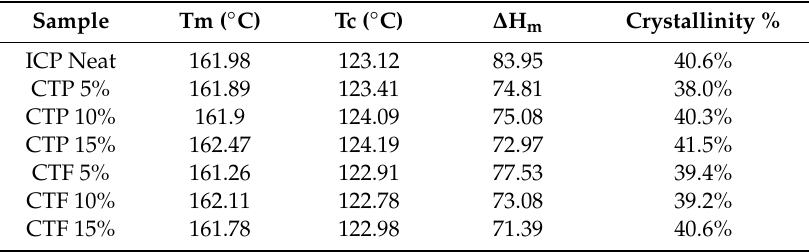
Table 7. Crystallinity index of treated fibers / ICP matrix